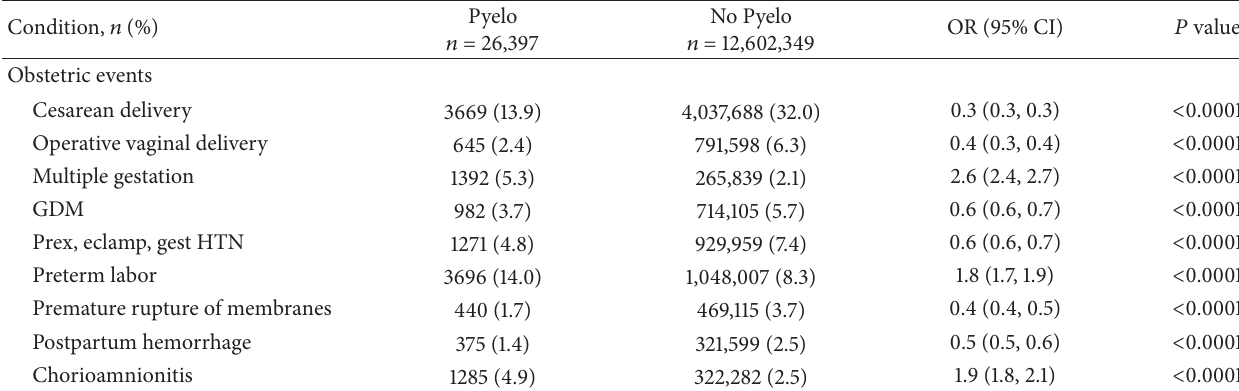
Table 4: Obstetric events present at time of delivery in hospital discharges among women with pyelonephritis compared to women without pyelonephritis, Nationwide Inpatient Sample years 2008–2010 (12,628,746